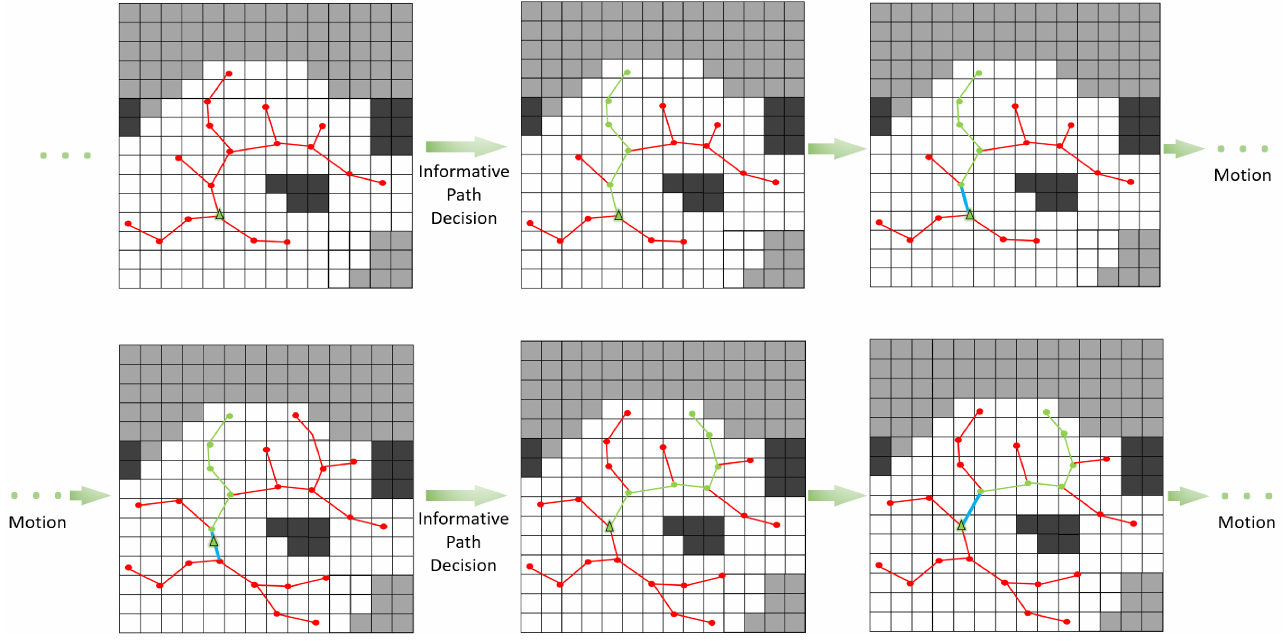
Figure 4. Process the planning loops till the termination of the exploration. The green triangle represents the current state of the robot, while the green lines represent the optimal informative path and the blue line represents the executive path in one period. The red lines depict the maintained roadmap. The red and green dots represent the nodes. The white, gray, and black grids represent free, unknown, and occupied space